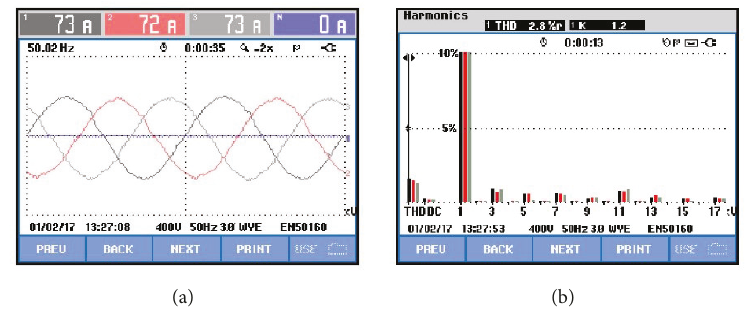
Figure 18: The experimental waveforms and THD of grid currents using the single update PWM ( 𝑘